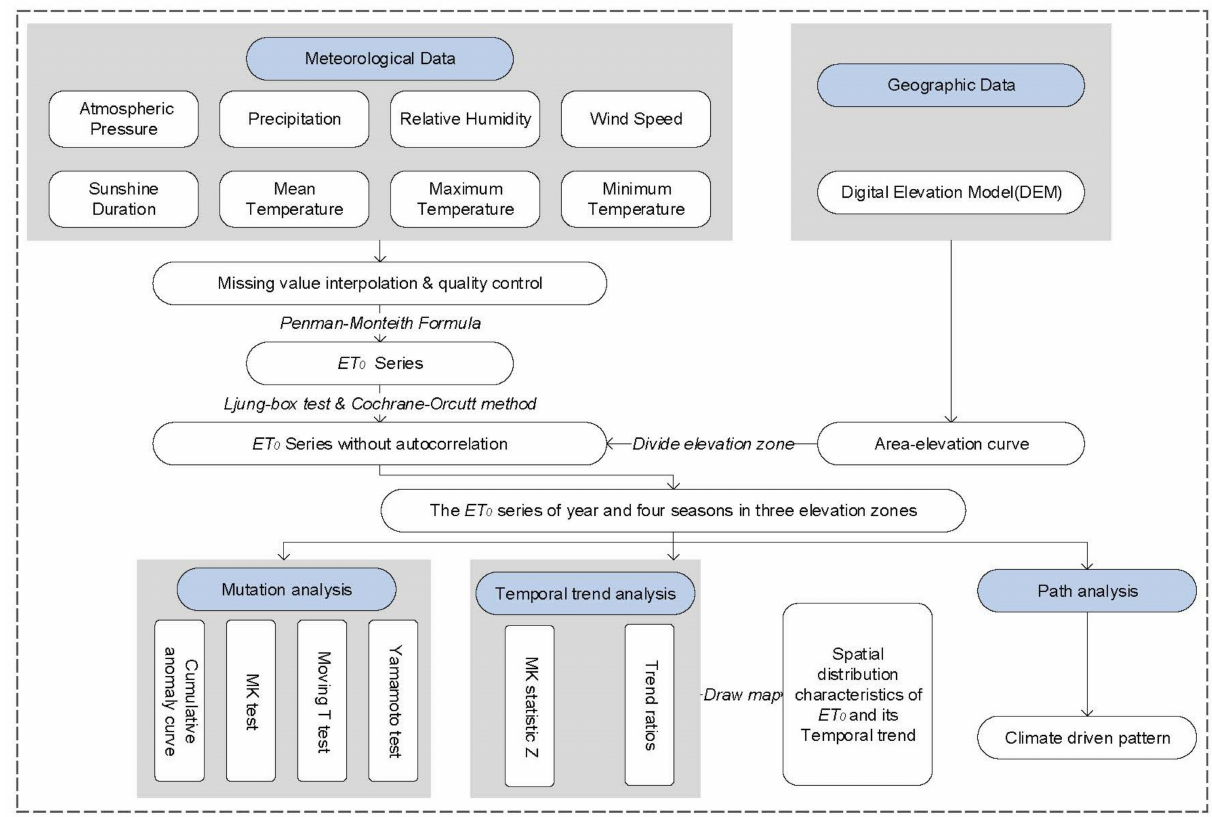
Figure 4. The flowchart of this